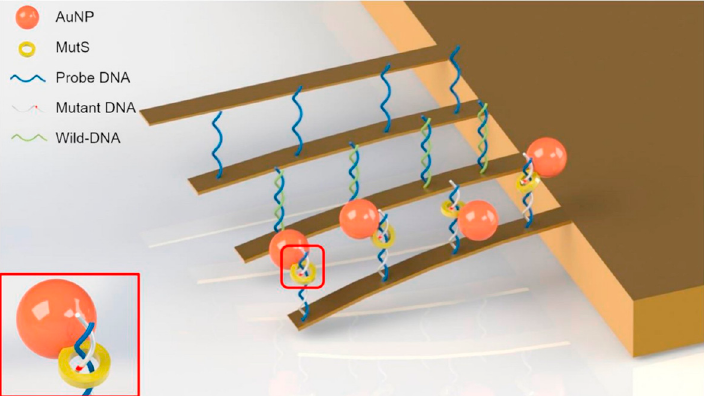
Figure 8. Schematic illustration of the Kirsten rat sarcoma viral oncogene homolog (KRAS) mutation detection using MutS, AuNP, and resonator [127].